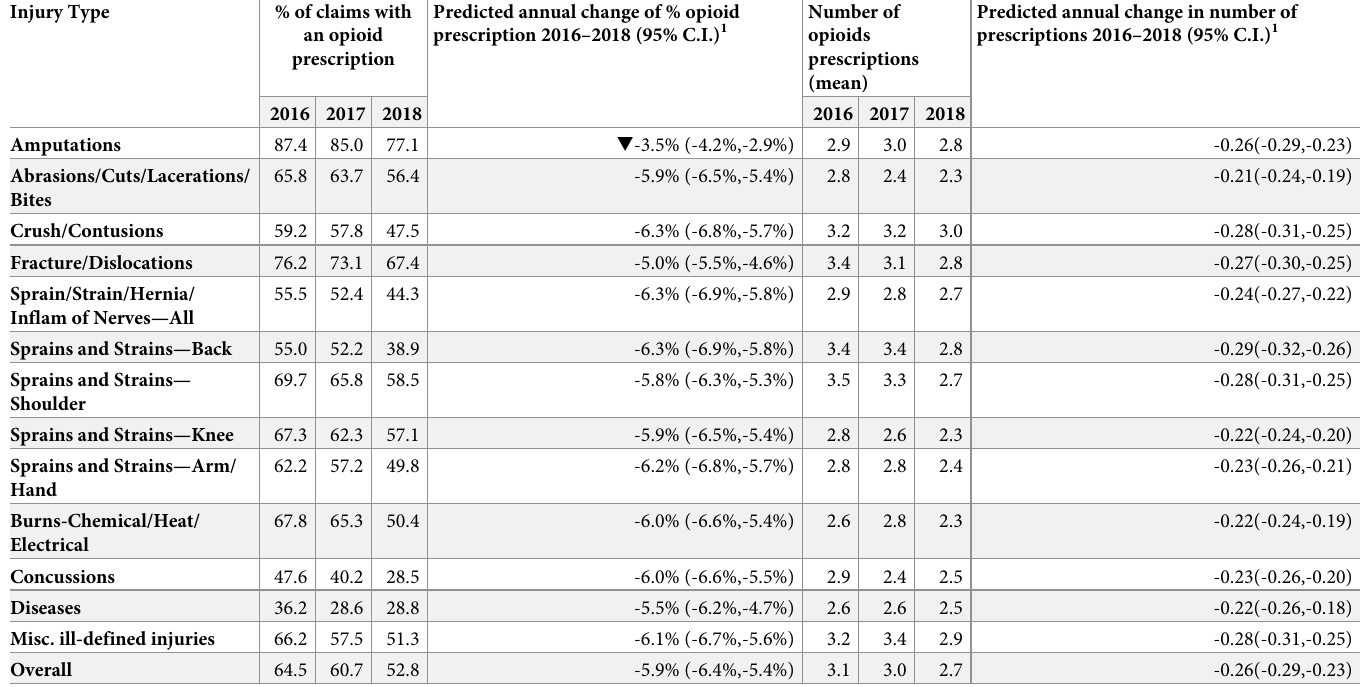
Table 5. Percent of claims with an opioid prescription and number of opioids prescriptions within 6 months of a paid wage replacement WC claim by injury type and year,